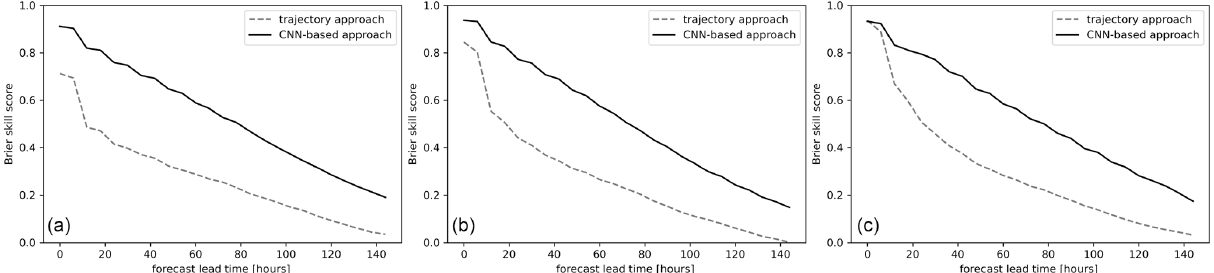
Figure 5. Mean Brier skill score for WCB (a) inflow, (b) ascent, and (c) outflow forecasts of ECMWF’s operational ensemble forecasts averaged over the region shown in Fig. 4.